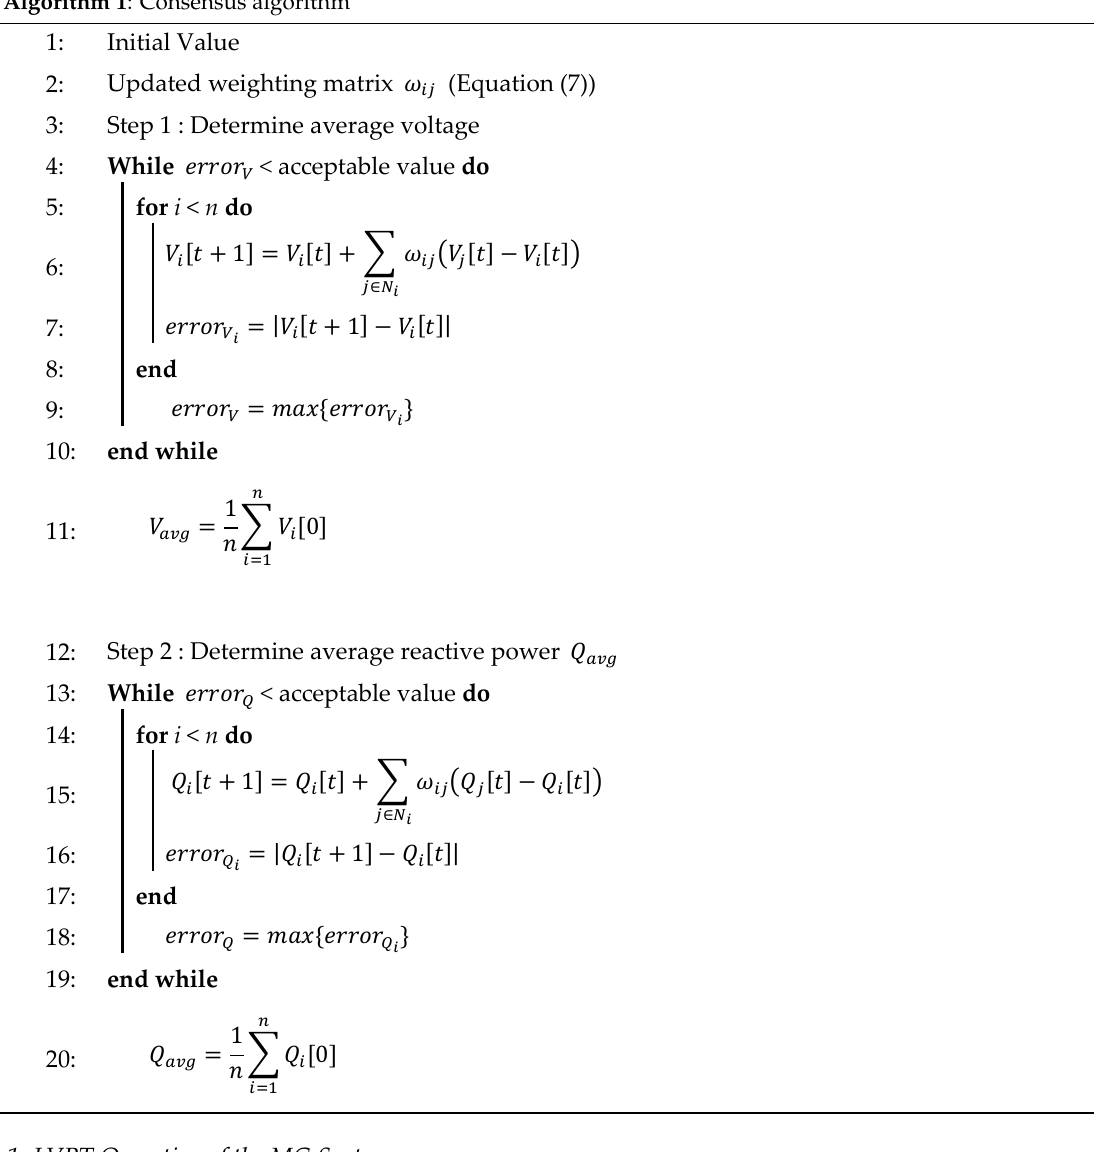
Algorithm 1 : Consensus algorithm